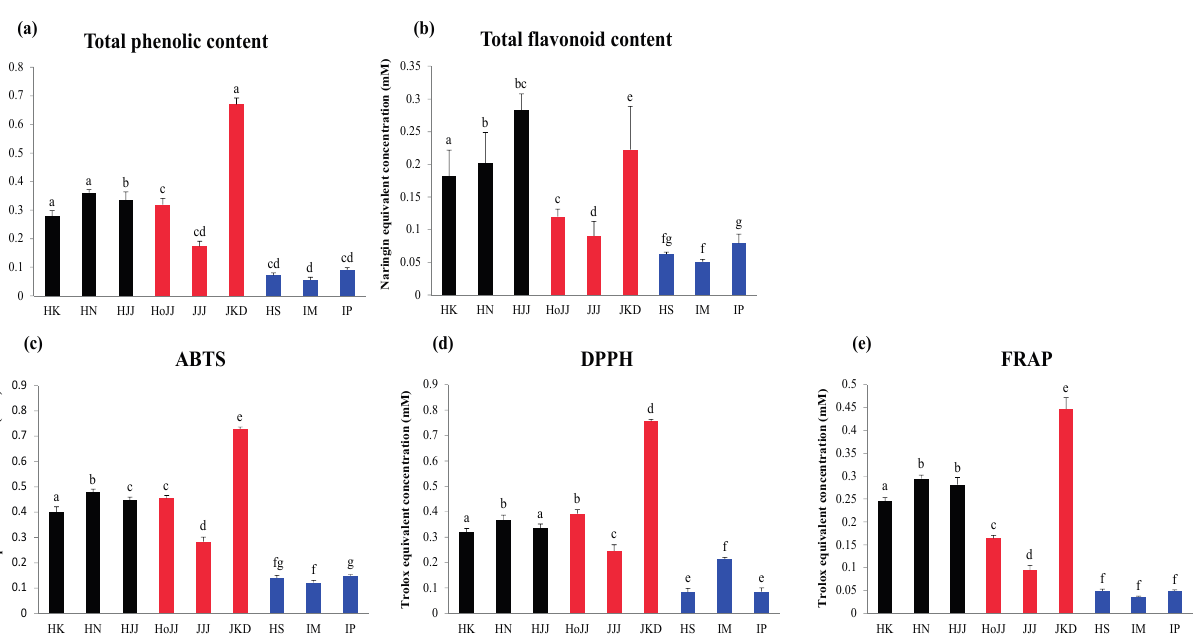
Figure 3. Total flavonoid contents ( a ), total phenolic contents ( b ), and antioxidant activity assays, ABTS ( c ), DPPH ( d ), and FRAP ( e ) of nine different varieties of rice seeds. Values represent averages of triplicate measurements. Different letters indicate significantly different values, according to Duncan’s multiple range test.